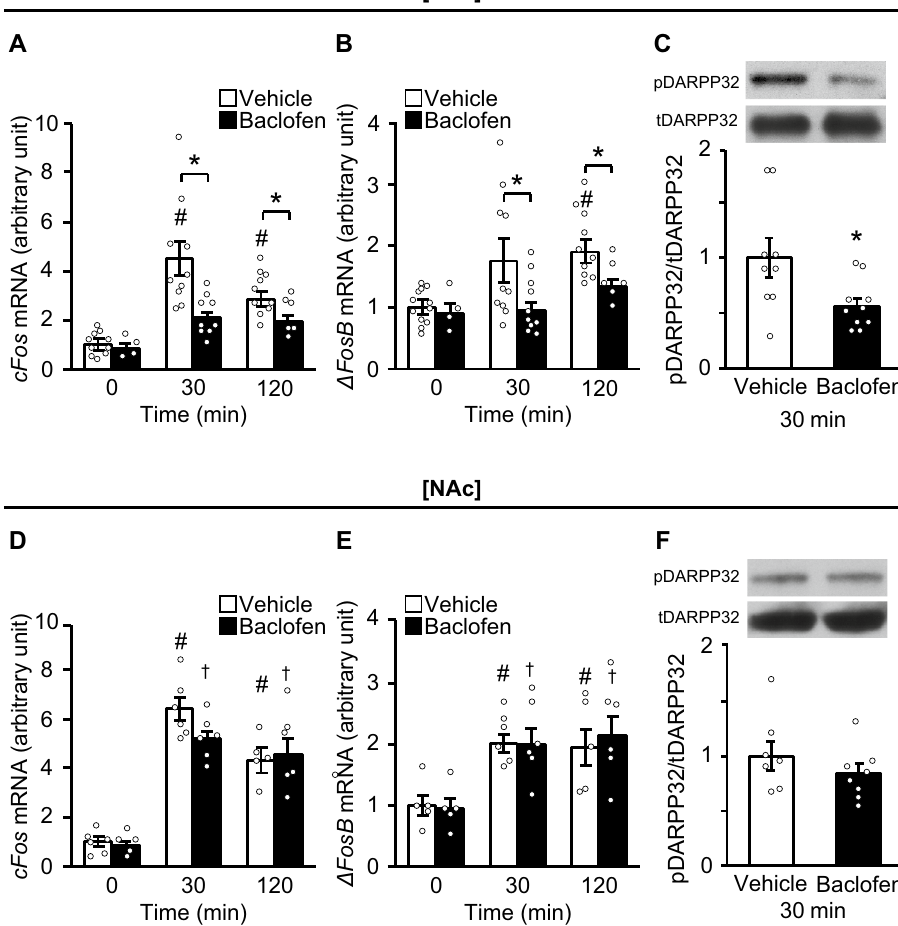
Figure 4. Baclofen suppresses cFos and ΔFosB mRNA expression levels as well as phosphorylation of DARPP32 in the CPu. ( A – C ) The mRNA expression levels of cFos ( A ) and ΔFosB ( B ), and phosphorylation of dopamine- and cyclic-AMP–regulated phosphoprotein of molecular weight 32,000 (DARPP32) protein ( C ) in the caudate putamen (CPu) in wild-type (WT) mice of the binge group treated with baclofen and vehicle. ( D – F ) The mRNA expression levels of cFos ( D ) and ΔFosB ( E ), and phosphorylation of DARPP32 ( F ) in the nucleus accumbens (NAc) in WT mice of the binge group treated with baclofen and vehicle. All values are mean ± SEM. Statistical analyses were performed using two-way factorial analysis of variance (ANOVA) ( A , B , D and E ) followed by Sidak’s post-hoc test or an unpaired t test (C and F). # p < 0.05 versus 0 min in WT mice. † p < 0.05 versus 0 min in KO mice. * p < 0.05 versus WT mice. See also Supplemental Table 2 for details on